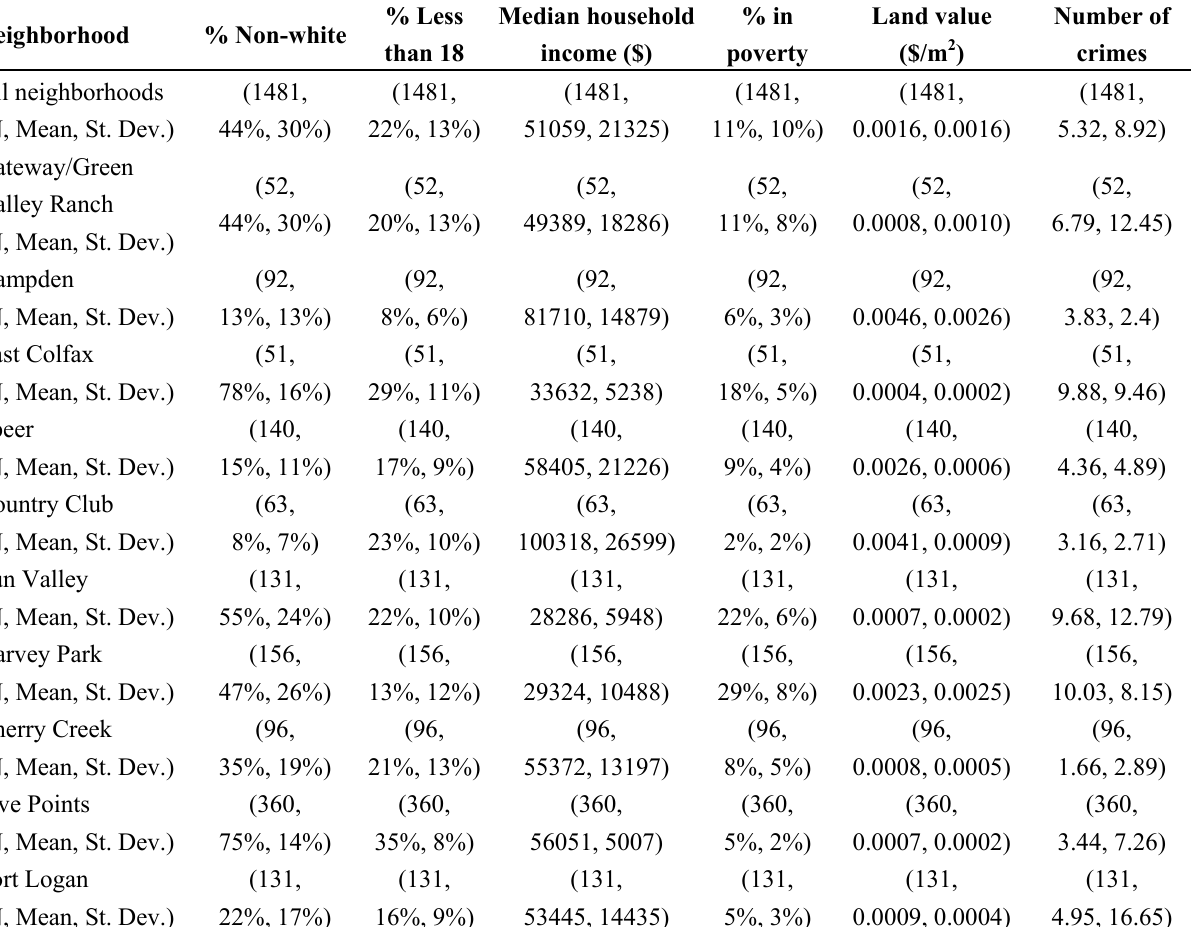
Table 2. Descriptive statistics of the equity variables for the 12 sampled neighborhoods.